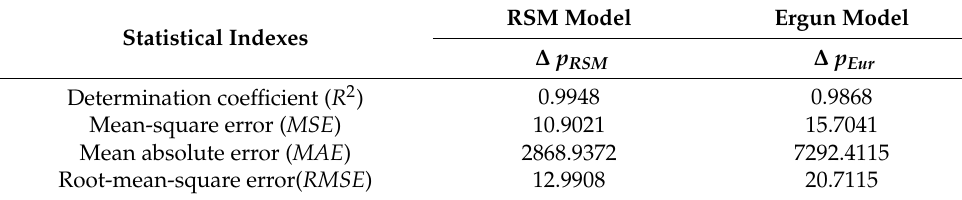
Table 6. The statistical results of the RSM experiment for comparing ∆ p RSM and ∆ p Eur . RSM Statistical Indexes